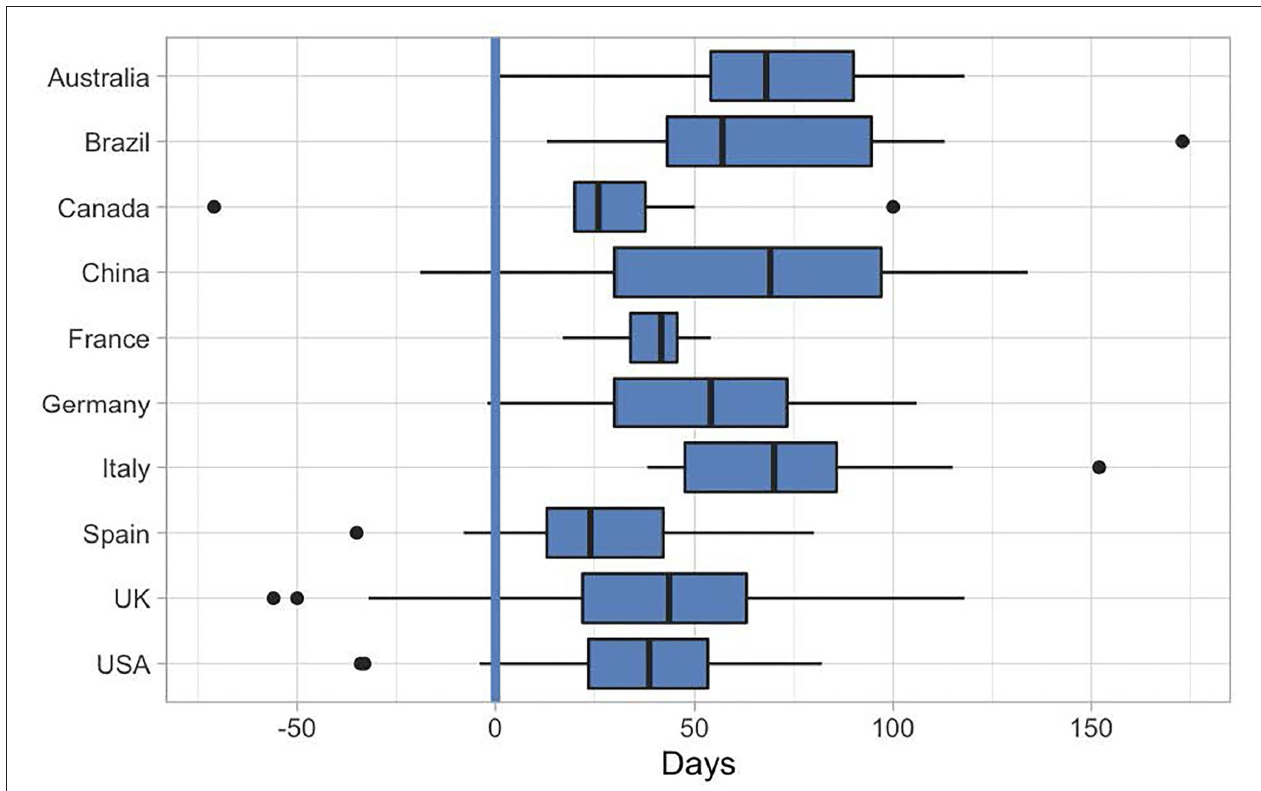
FIGURE 4 | Timing of participant sampling in relation to pandemic development. The speed with which researchers began collecting data on PA behavior change in the top 10 countries that contributed with the greatest number of studies. Day 0 is the day when the most severe confinement measures were installed in the respective country (according to the Oxford COVID-19 Government Response tracker; Hale et al.,